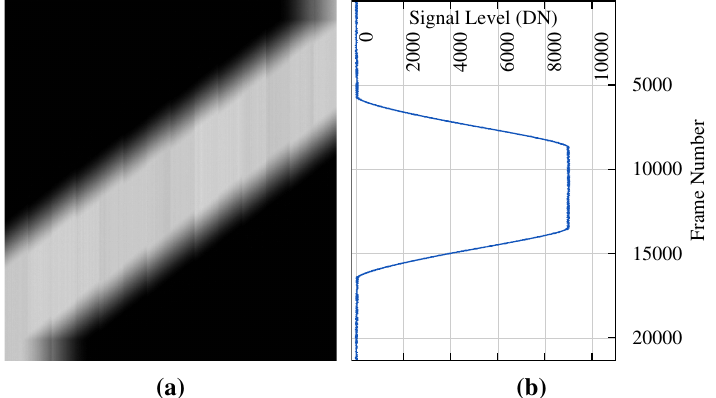
Figure 4. ( a ) Coastal aerosol band image of the yaw calibration scan. The OLI is pointed at the DSS and scanned across the aperture such that all detectors get a full view of the